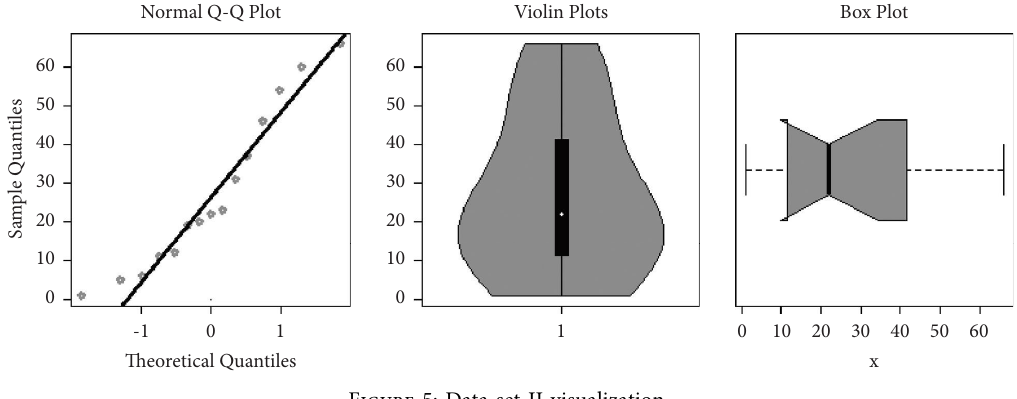
Figure 4: Te ftted PMFs for data set I.